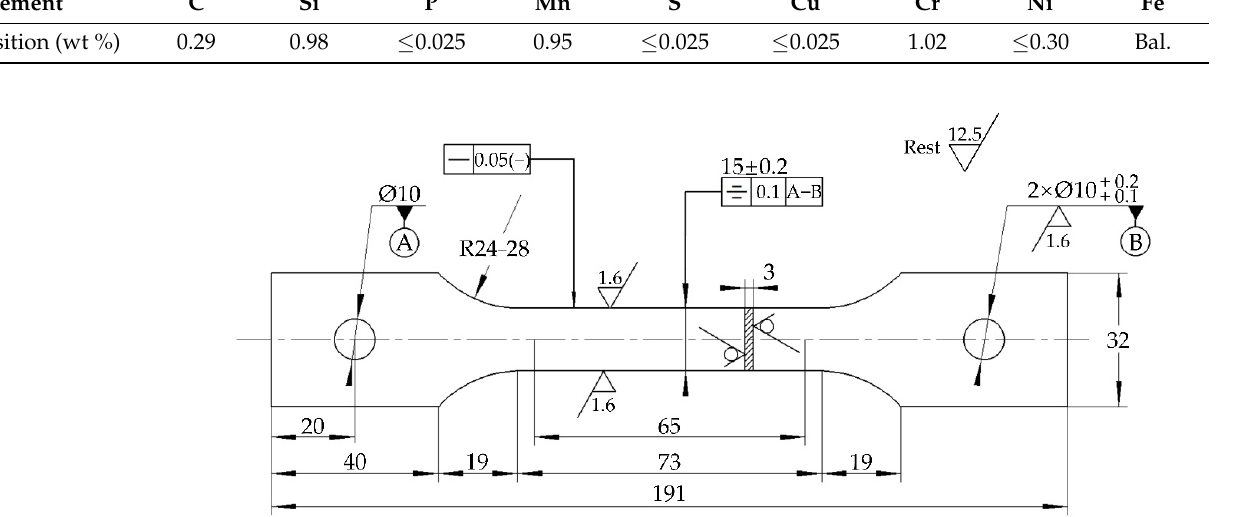
Table 1. Chemical compositions of the 30CrMnSiA high ‐ strength steel.